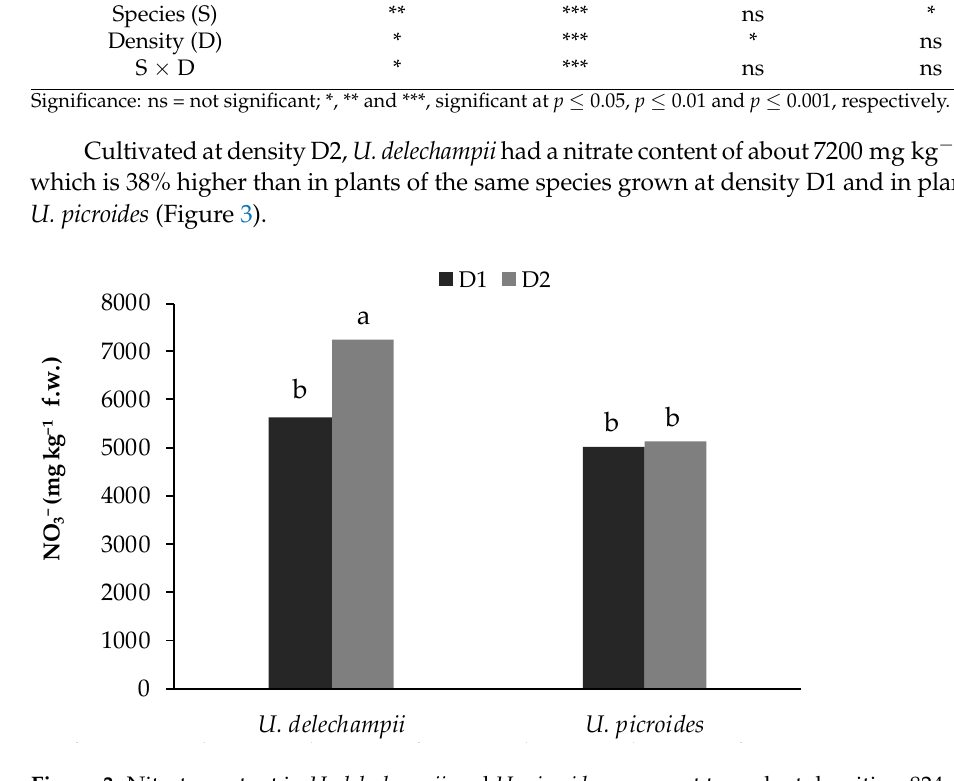
Figure 4. Chloride content in U. delechampii and U. picroides grown at two plant densities: 824 plants m −2 (D1) and 412 plants m −2 (D2). The same letters indicate mean values not significantly different ( p = 0.05).